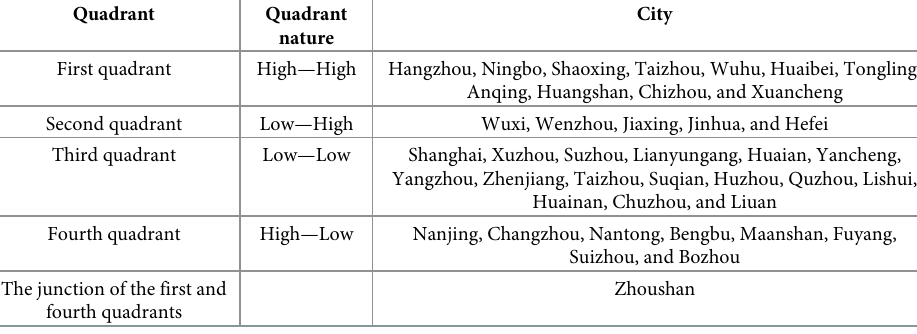
Table 6. Quadrant distribution of cities in the YRD region in 2019.